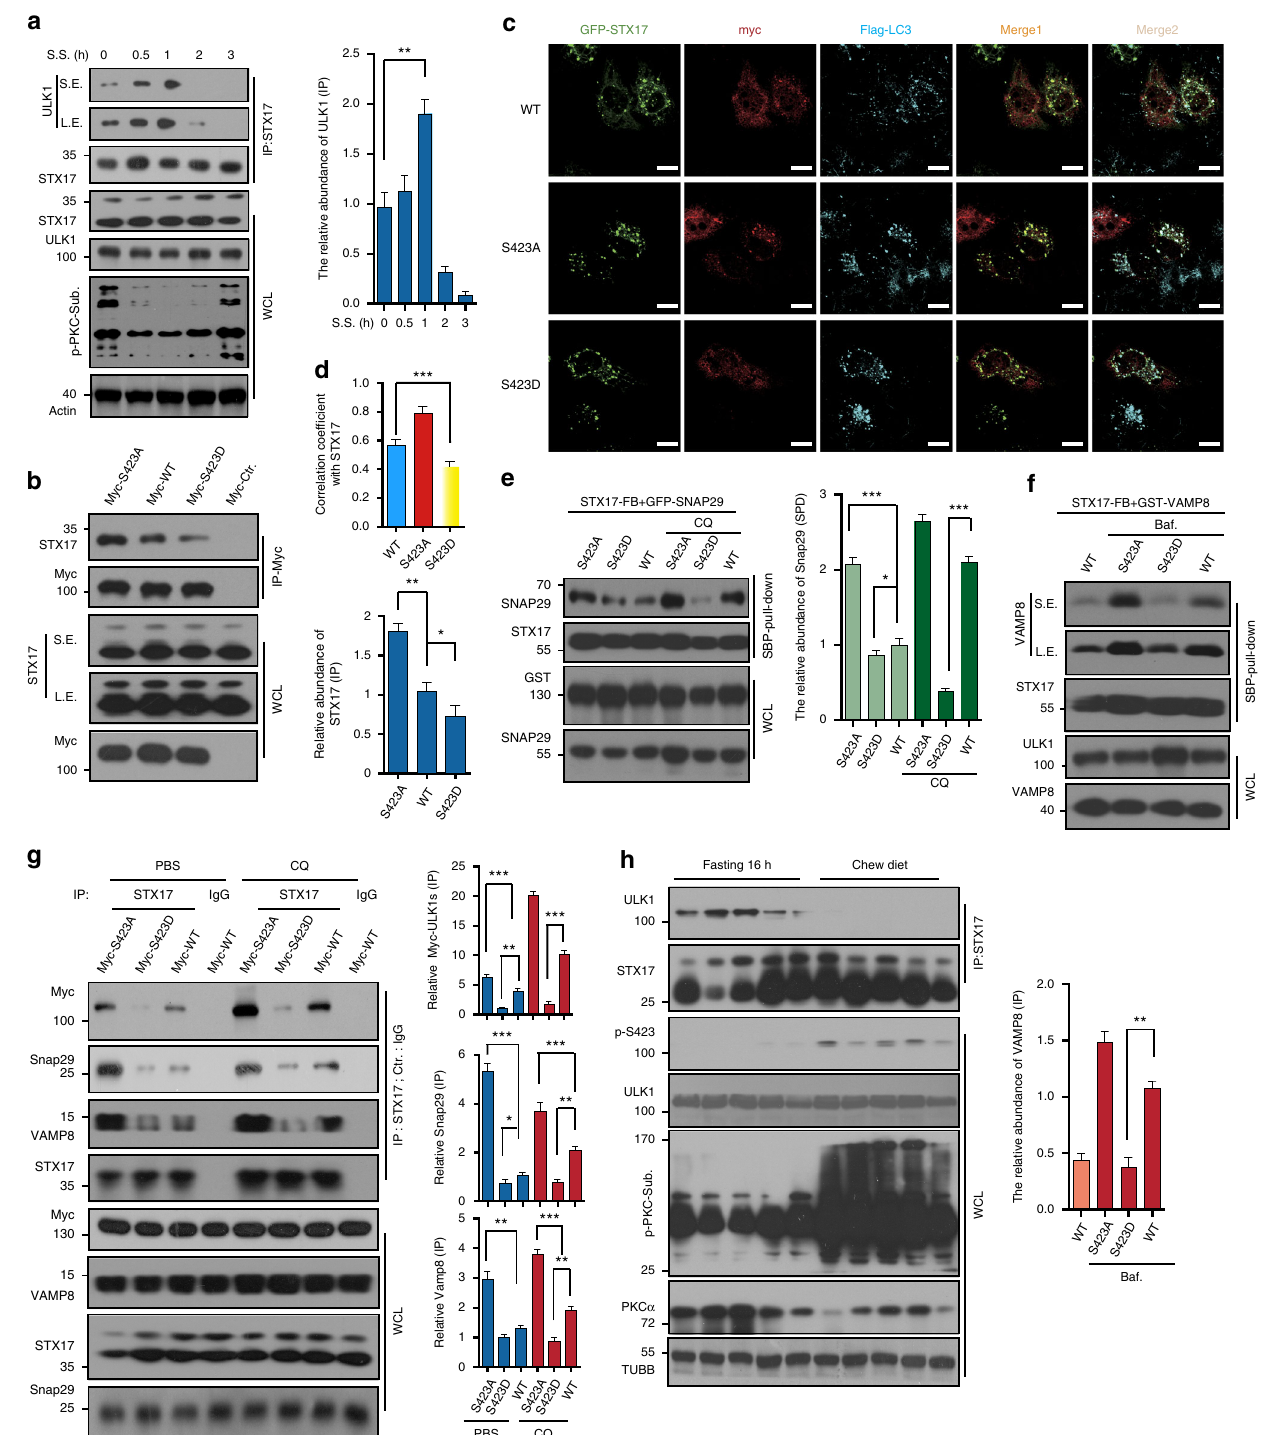
Fig. 5 Phosphorylation of ULK1 in fl uences the STX17 complex. a HeLa cells were starved and the lysates were performed with IP assay via STX17 antibody and analyzed with ULK1 antibody showed in the right top panel. IPed ULK1 is quanti fi ed and showed in the right bottom panel. b ULK1 S423D decreased binding to STX17 compared to WT and S423A by IP assay. In addition, IPed STX17 was quanti fi ed. c , d GFP-STX17, Flag-LC3, and Myc-ULK1 variants were cotransfected and detected by immunostaining in HeLa cells ( n = 20), and the images were quanti fi ed ( d ). Scale bars, 10 μ m. e , f ULK1 S423D affects interactions between STX17 and SNAP29 or VAMP8 with cotransfection and IP assay. The results were analyzed with the indicated antibodies. Bound SNAP29 and VAMP8 were quanti fi ed. g myc-ULK1 variant transfected HeLa cells were treated with CQ (100 nM) or PBS. IP assay was performed with STX17 antibody or IgG and detected by indicated antibodies. IPed proteins were quanti fi ed. h Lysates from the livers of fasting or normal chew mice were performed by IP assay with STX17 antibody and analyzed with ULK1 antibody. All values are means ± SEM of three independent experiments. Student ’ s t -test (unpaired); * p < 0.05, ** p < 0.01, *** p < 0.001. Baf: ba fi lomycin a1, WCL: whole-cell